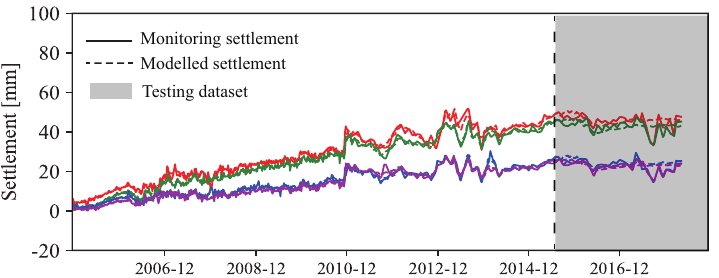
Figure A1. Fitting and prediction results of M–LSTM model based on the training datasets in Cluster 1 (LD1-2 in red lines and LD3-5 in green lines).